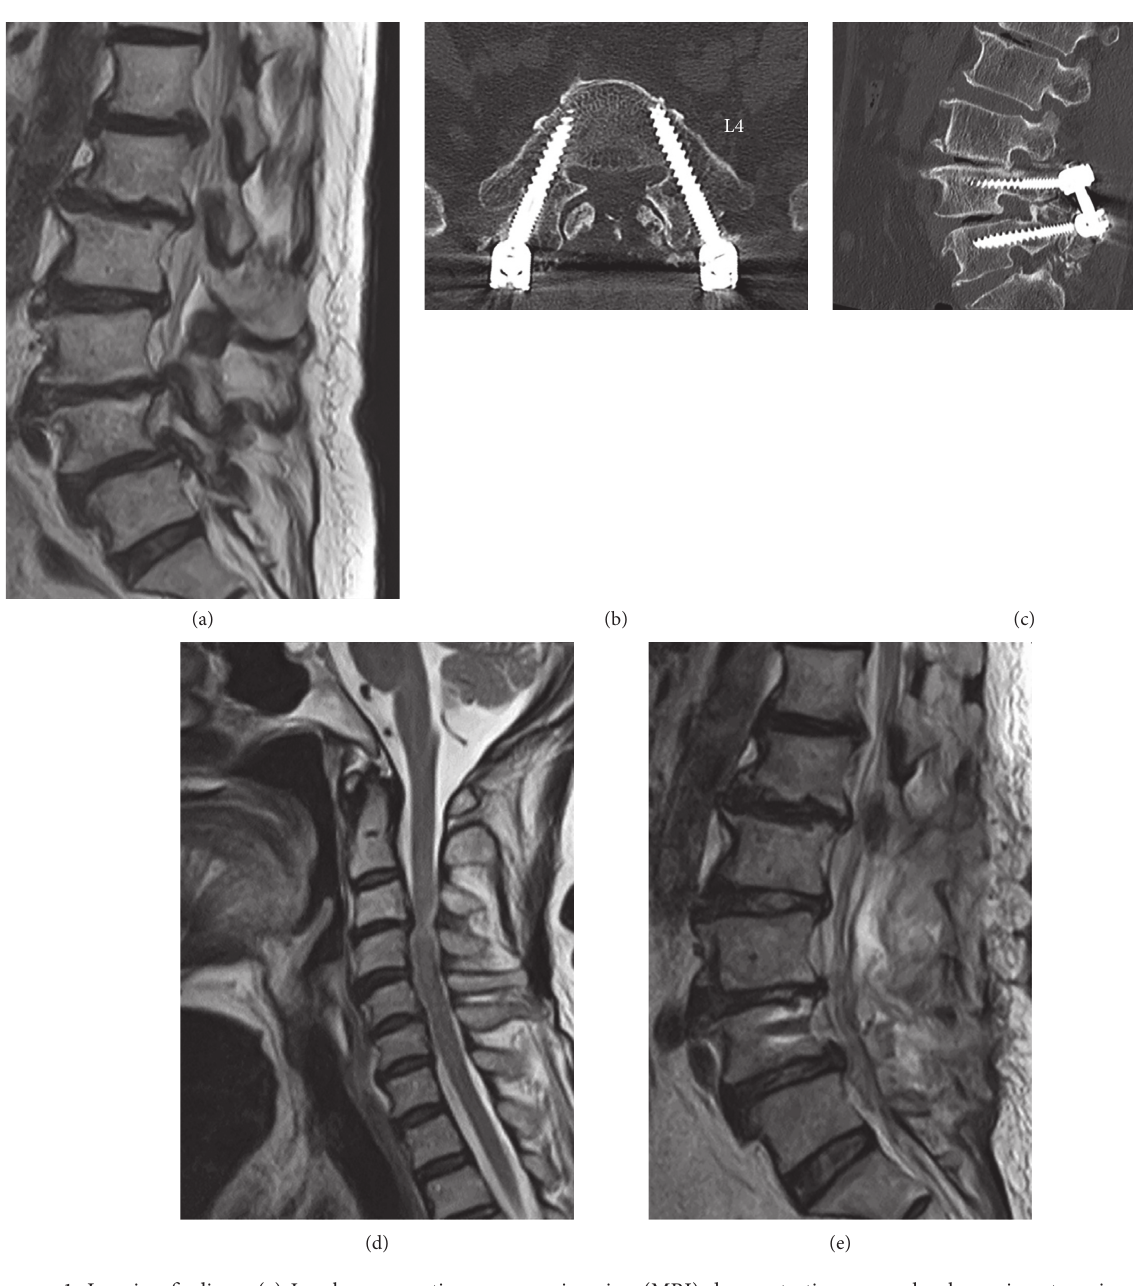
Figure 1: Imaging findings. (a) Lumbar magnetic resonance imaging (MRI) demonstrating severe lumbar spine stenosis at L1–5 and spondylolisthesis at L4/5. (b), (c) No percutaneous pedicle screw deviation or compression observed in the spinal canal. (d) Cervical MRI revealing spinal canal stenosis extending to C4–6 and disc herniation at the C3/4 level. (e) Lumbar MRI showing bilateral foraminal narrowing at the L4/5 level after laminectomy for L4 anterior spondylolysis, but no apparent implant